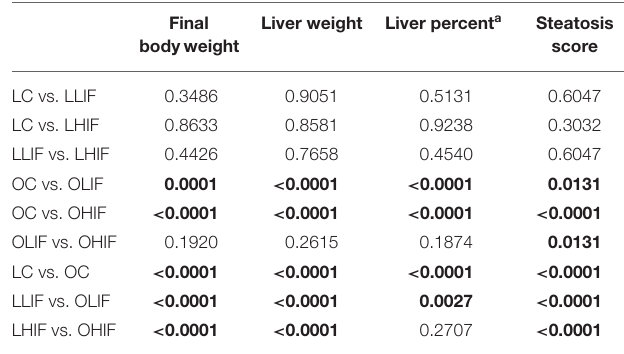
TABLE 2 | Mean body weight (g) ± standard deviation, liver weight (g), liver weight as percent of body weight and steatosis score for lean and obese rats on soy protein concentrate and casein control diet.